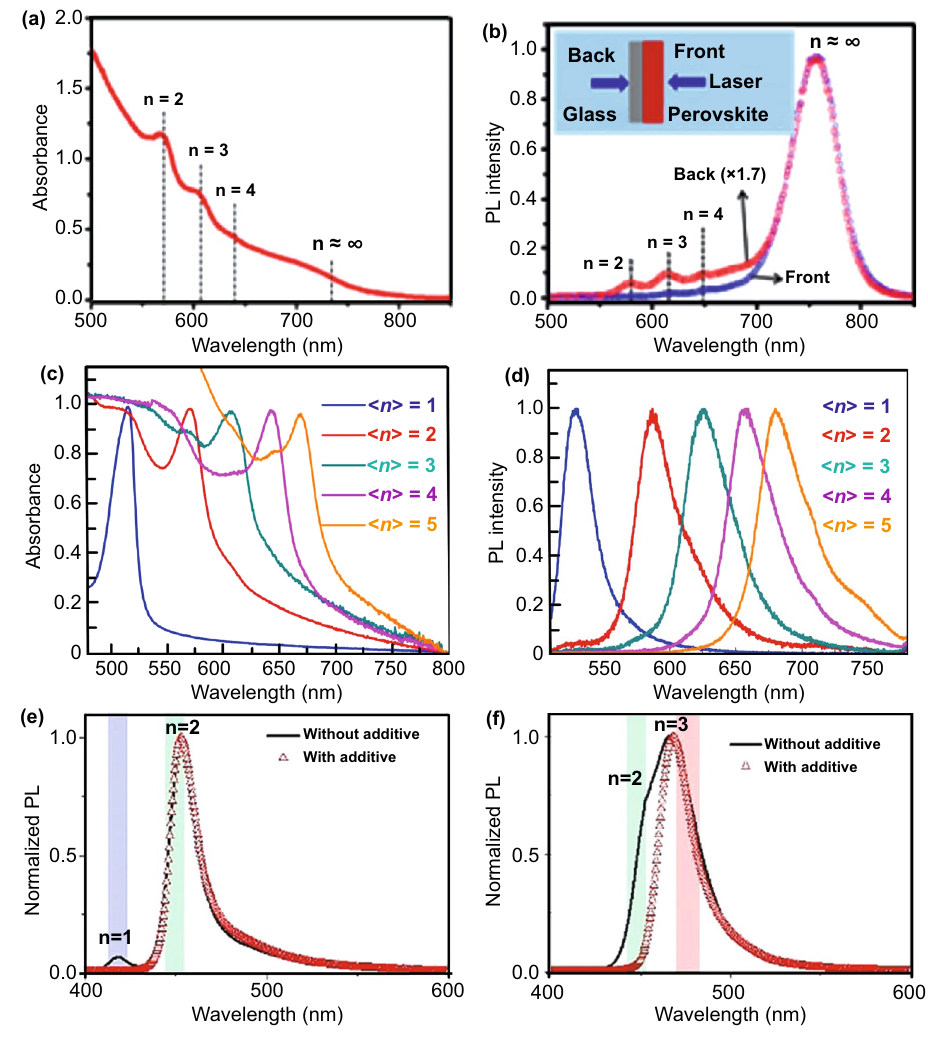
Fig. 2 a UV–Vis absorption spectra of (BA) 2 (MA) 3 Pb 4 I 13 perovskite film. b Comparison of the emission spectra of the 2D perovskite film illuminated from the front and back sides of the film. Copyright 2018 American Chemical Society [59]. c Normalized UV–Visible